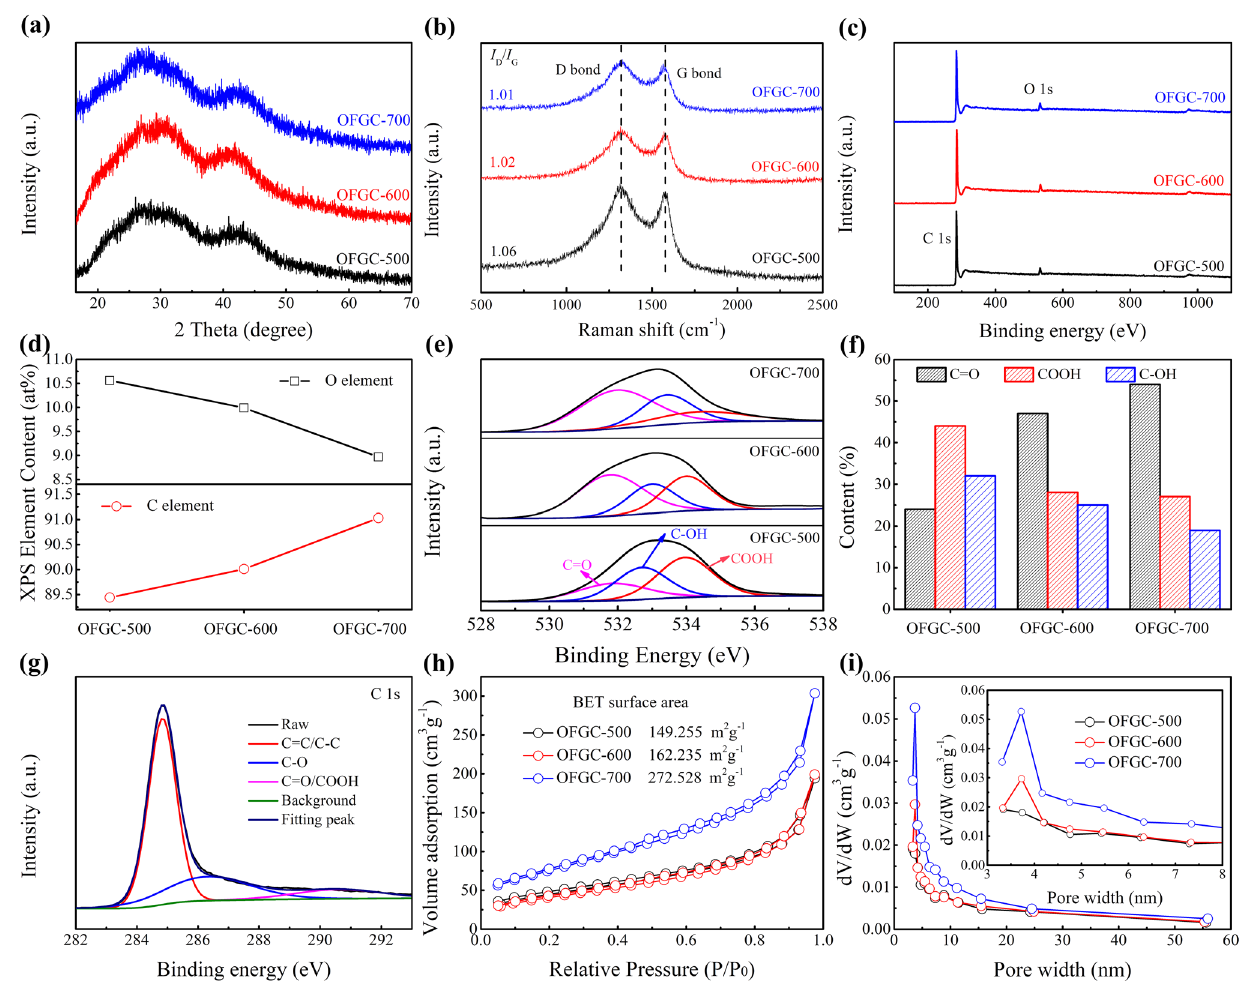
Fig. 2 The physical and chemical properties of OFGC-500/600/700. a XRD patterns. b Raman spectra. c XPS survey spectra, and d element content of C and O. e High-resolution XPS spectra of O 1 s , and f the content of C–OH, COOH, and C = O functional groups. g High-resolution XPS spectra of O 1 s of OFGC-600. h Nitrogen adsorption–desorption isotherms of OFGC-500/600/700. i The total pore size distribution and the micropore size distribution